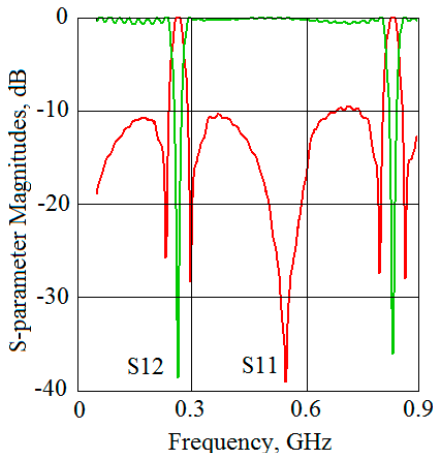
Figure 5. S-parameter magnitudes of the coaxial bandstop filter model.